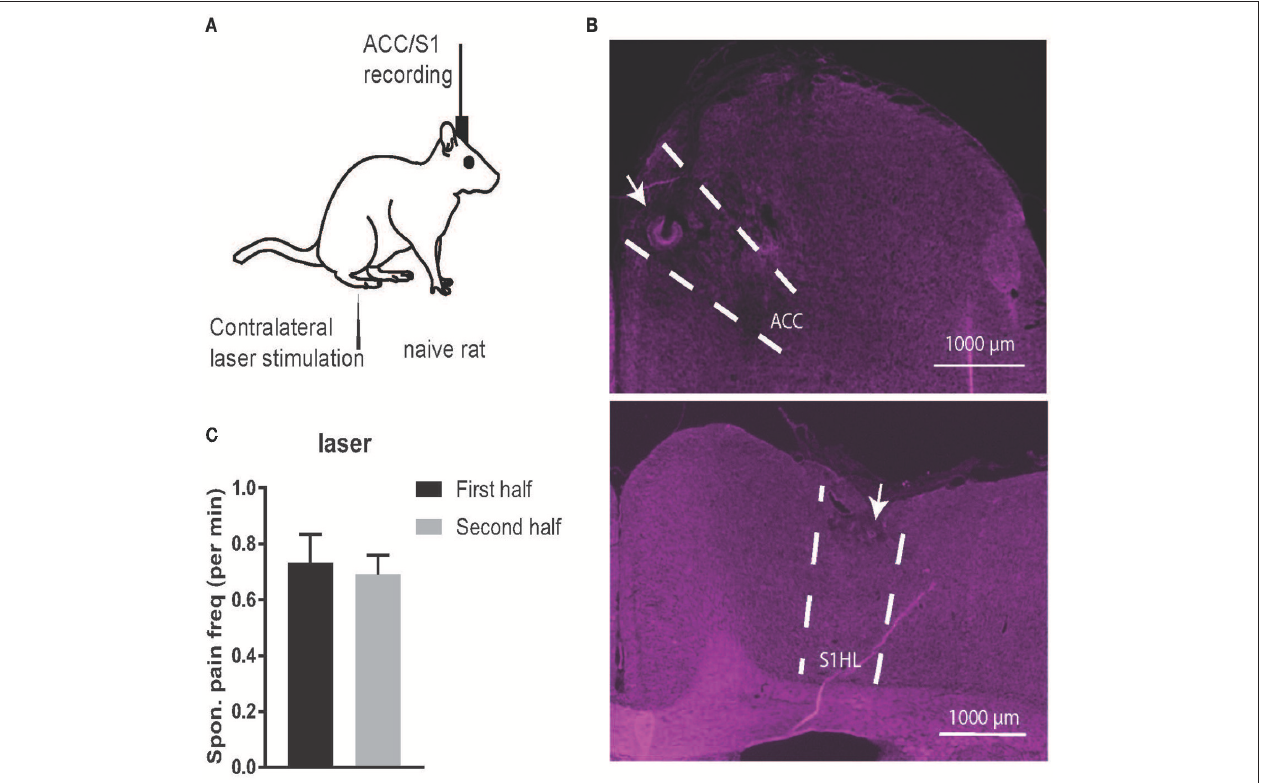
FIGURE 1 | (A) Schematic diagrams of noxious stimulation and recording on naive rats. (B) Histology of recording areas in the rat ACC and S1. (C) Comparison of the frequency (per minute) of spontaneous pain-like episodes between the first and second half of recording sessions. There was no statistical difference between the first and second half ( p > 0.05, paired t